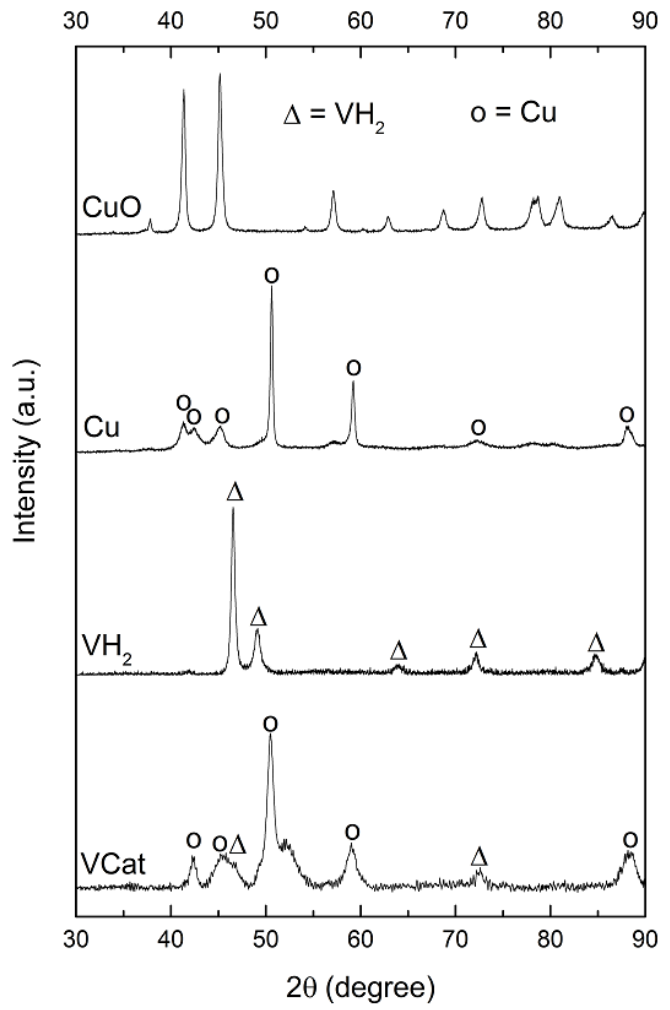
Figure 1. XRD profiles of VCat, VH 2 , Cu and